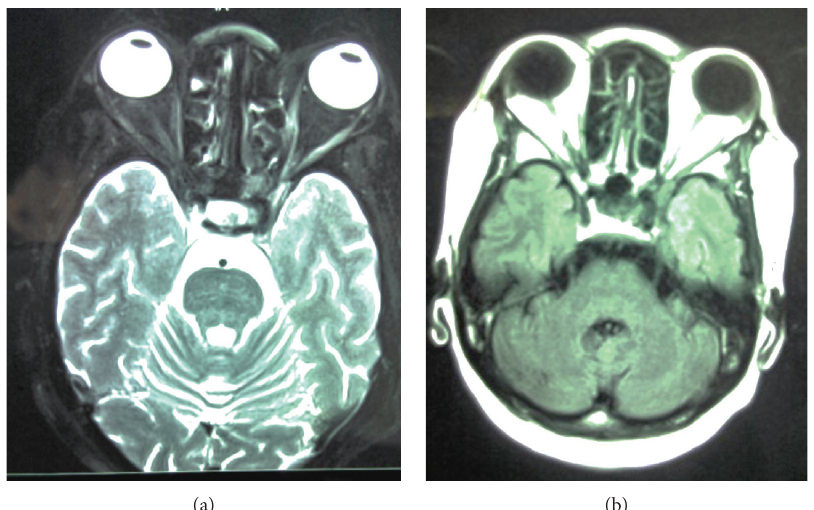
Figure 2: MRI axial slice of the brain in (a) T2 sequence and (b) T2-FLAIR sequence after contrast injection showing no abnormalities in the cavernous sinus.